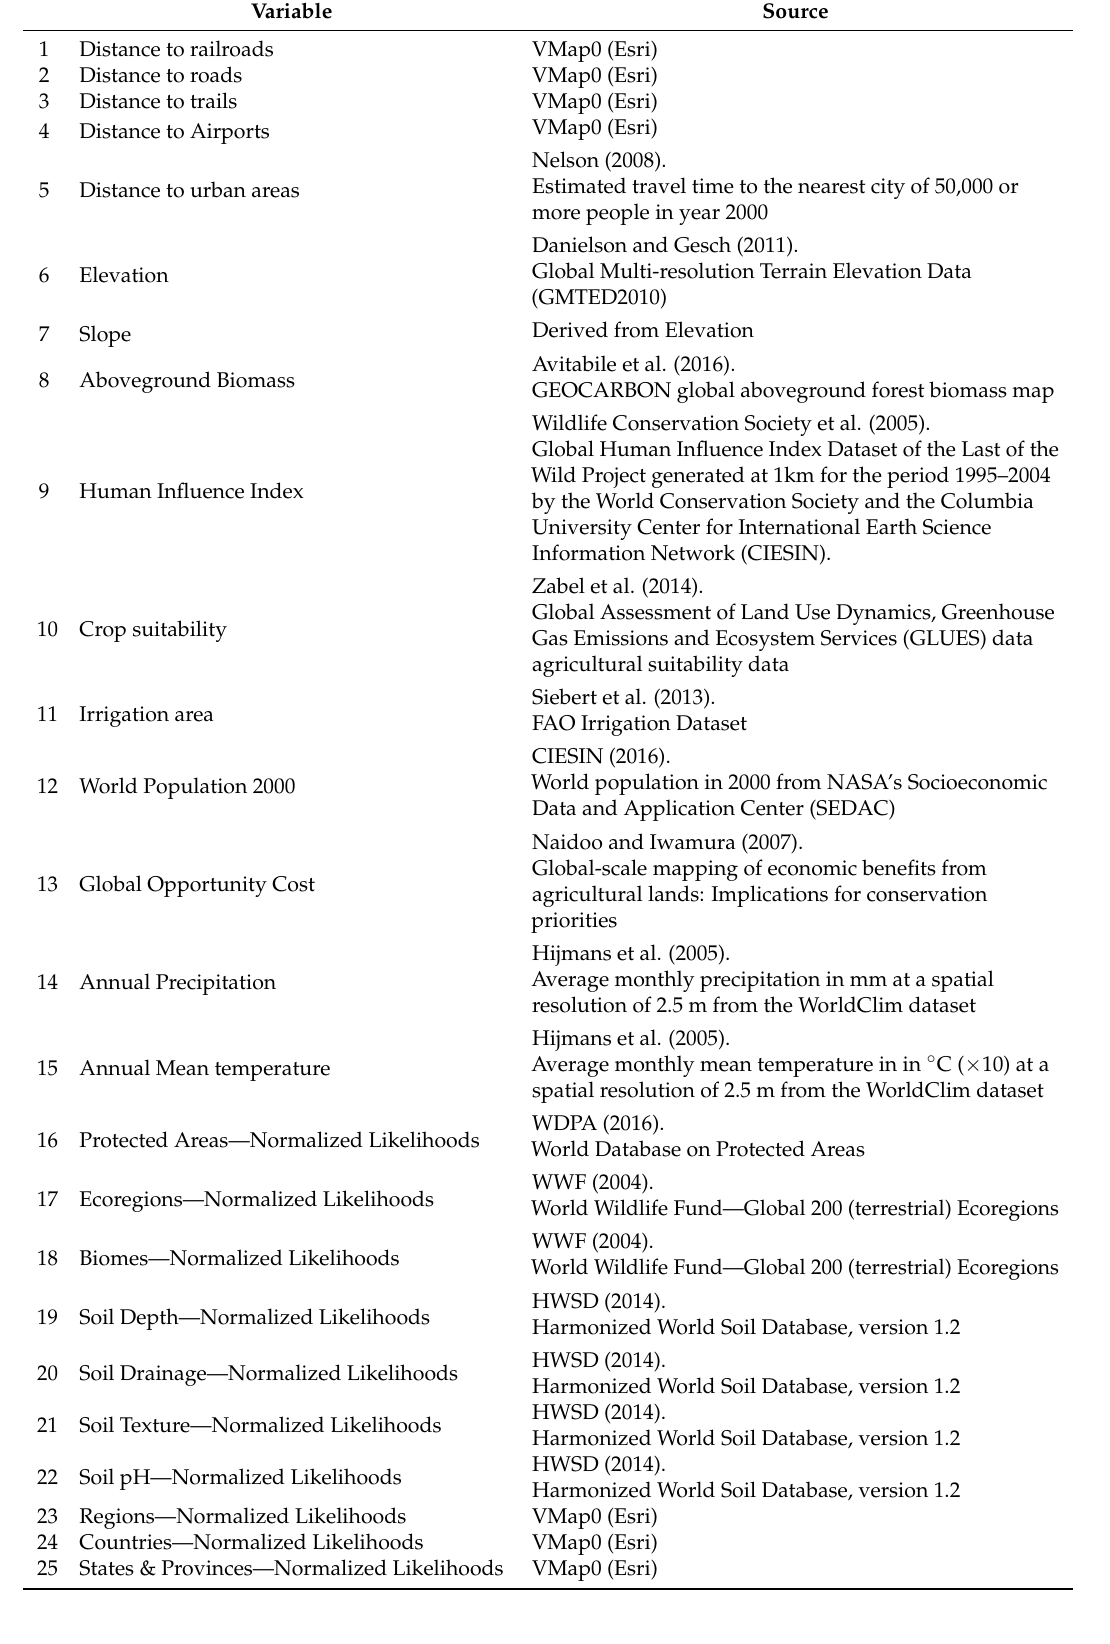
Table 1. Initial set of variables (and data sources) considered for inclusion in the models at both scales, including; quantitative (1–15) and qualitative variables